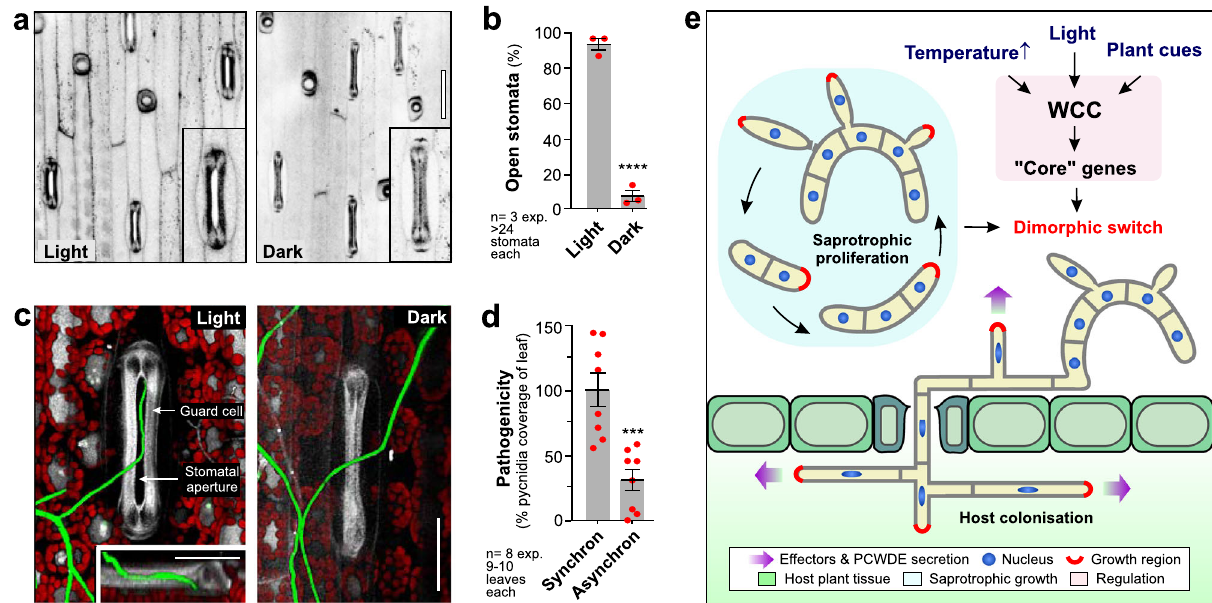
Fig.9|Effectofalteredlightphaseoninfection.a Contrastinvertedimagesofthe upper leaf epidermis in light or dark. Insets show enlarged stomata. Scale bar=50 µ m. b Percentage of open stomata in light and dark. c Z. tritici hyphae, expressing cytoplasmicGFP(green),onwheatleaves,growninlightordark.Hyphaeenteropen stomata (Light) but pass over closed stomata (dark). A guard cell and the stomatal aperture are indicated. Chloroplasts are shown in red. Scale bars=3 µ m in side-view insert; 30 µ m in overviews. d Disease symptoms in infection assays under different lightconditions.Synchron=hostandpathogengrownunderthesame12hlight/12h darkness regime; Asynchron=host and pathogen grown 12h out of phase. e Model of the role of WCC in controlling dimorphicswitching and pathogenicity in Z. tritici . During saprotrophic growth in plant debris, Z. tritici proliferates cell numbers by forming multi-cellular blastospores by lateral budding. On wheat leaves, the white-